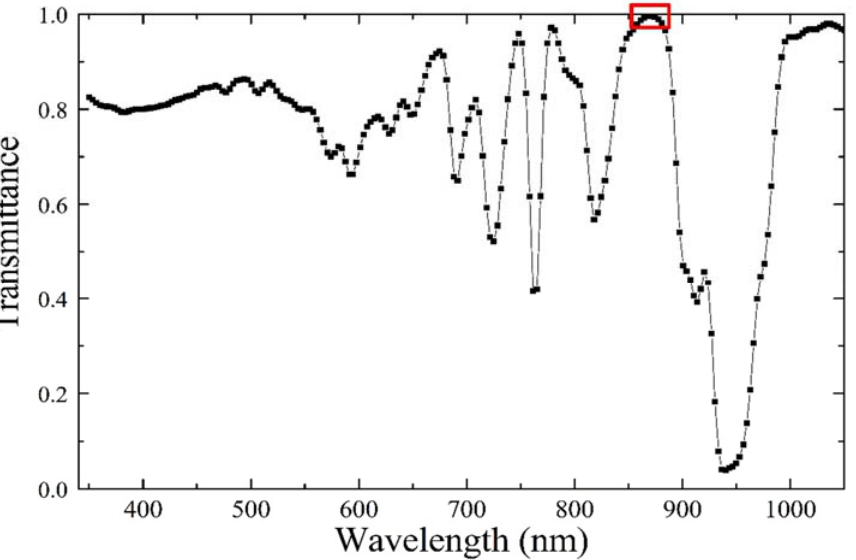
Figure 6. Atmospheric gaseous transmittance, T g = T o · T tg · T mg · T w , simulated by SMARTS using the inputs given in Figure 5 for 2021-04-04. A red rectangle is added to highlight a particular spectral band (864.5 − 874.4 nm) where the atmosphere is almost transparent to solar radiation except for the a tt enuation processes caused by molecular and aerosol sca tt ering.